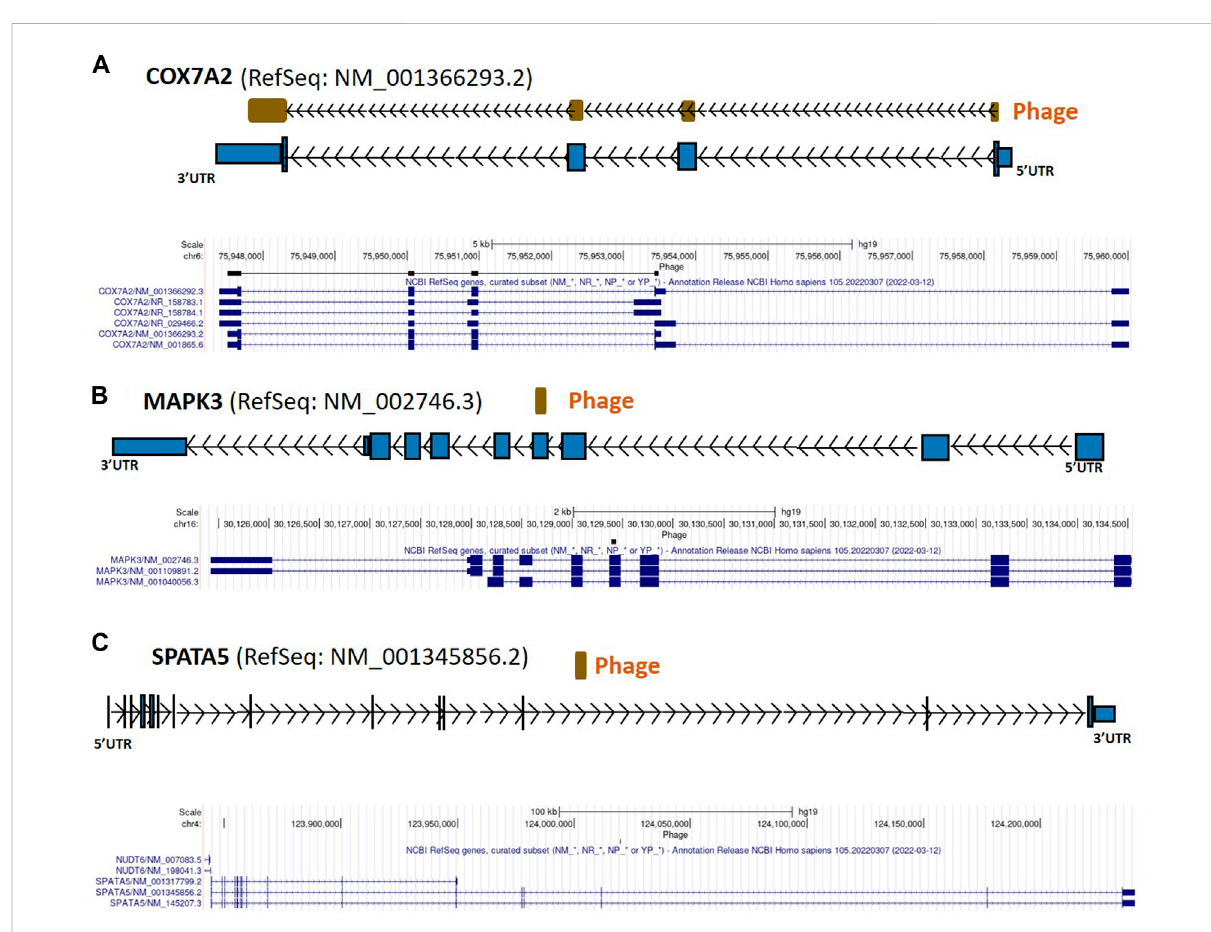
FIGURE 3 COX7A2 , MAPK3 ,and SPATA5 generegionsasautoreactive BCantigens identi fi edbyUCSCGenomeBrowser BLATmappingandannotationof uniquely patient-sera-reactive phages. (A) Identi fi ed phage mapping within protein-coding region of COX7A2 gene. (B) Identi fi ed phage included protein-coding region of MAPK3 . (C) Identi fi ed phage mapped completely within an intron of SPATA5 . COX7A2 , cytochrome c oxidase polypeptide 7A2; MAPK3 , mitogen activated protein kinase 3; SPATA5 , spermatogenesis associated protein 5; UTR, untranslated region; kb,